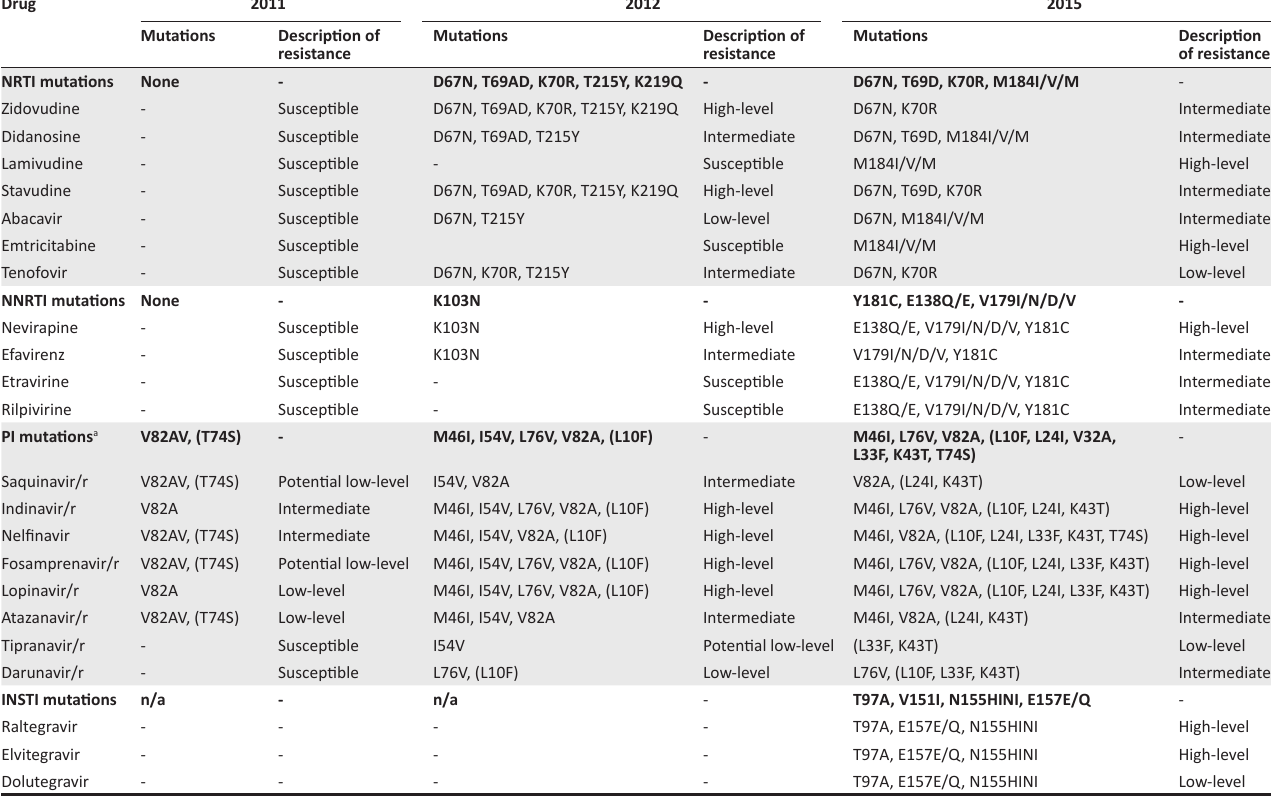
TABLE 1: HIV genotypic drug resistance test results for 2011, 2012 and 2015.